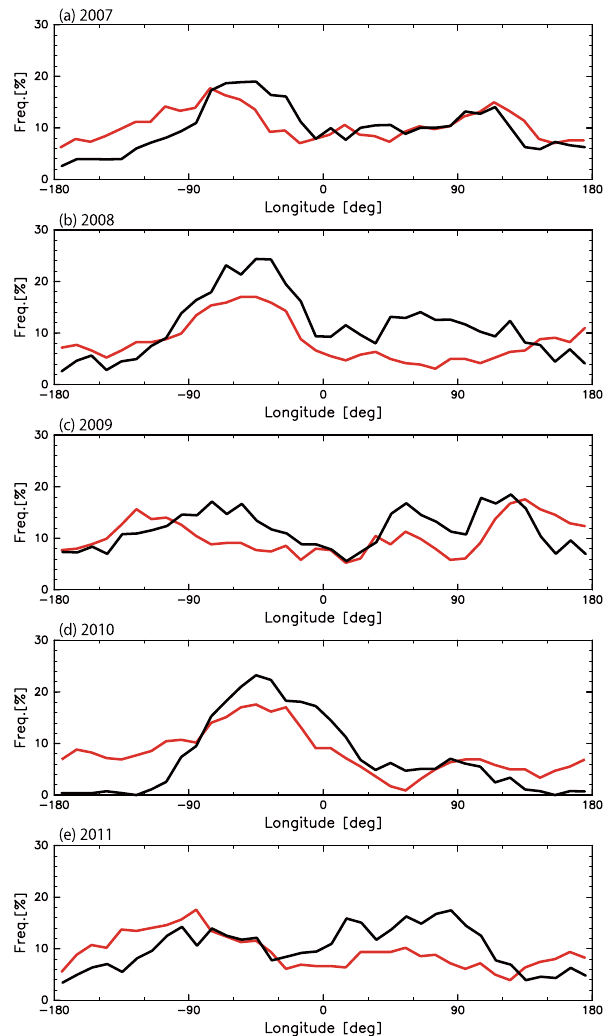
Fig. 10. Black curves show frequencies of simultaneous observa- tions of PSCs in the altitude range of 15–25km and UCs at 9–11km as functions of longitude from June through September (a) 2007, (b) 2008, (c) 2009, (d) 2010 and (e) 2011. Red solid curves show frequencies of blocking highs calculated for the region only inside the polar vortex on a 500K isentropic